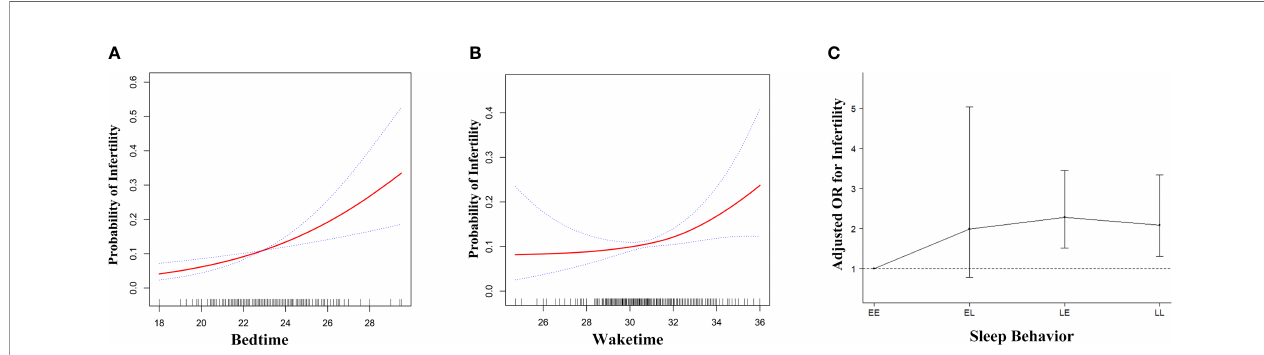
FIGURE 2 | Adjusted associations of bedtime (A) , waketime (B) and sleep-wake behavior (C) with infertility in unweighted sample, respectively. While there was a positive linear association between bedtime and fertility (A) , a threshold, nonlinear association between waketime and fertility (B) was found in generalized additive models (GAM). Solid red line represents the smooth curve fi t between variables. Blue bands represent the 95% of con fi dence interval from the fi t. Each of the three independent variables, bedtime (A) , waketime (B) and sleep-wake behavior (C) was adjusted for age, race, BMI, education, marital status, physical activity, poverty level index, cotinine, bedtime, waketime and sleep duration except for the variable itself. EE, Early-bed/Early-rise; EL, Early-bed/Late-rise; LE, Late-bed/Early-rise; LL, Late-bed/Late-rise; OR, odds ratio; BMI, body